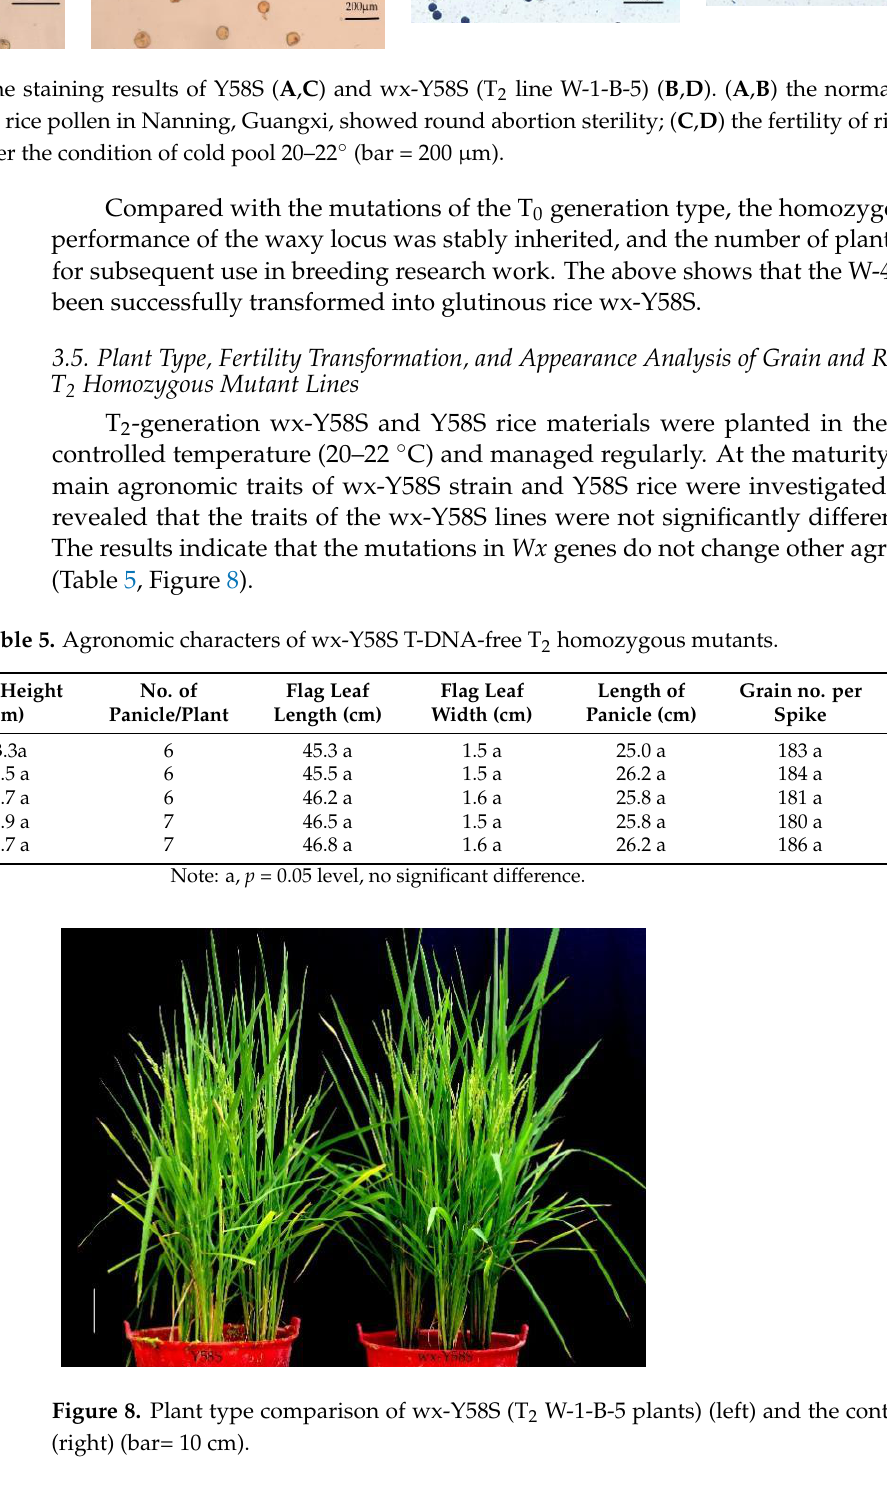
summery condition of rice pollen in Nanning, Guangxi, showed round abortion sterility; ( C , D ) the fertility of rice pollen